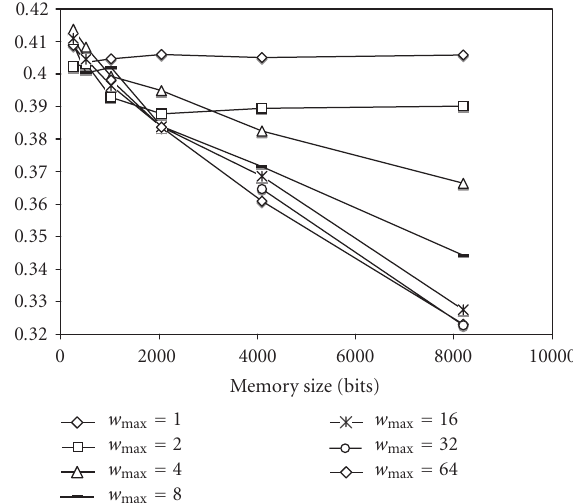
Figure 10: Impact on routing energy when increasing memory